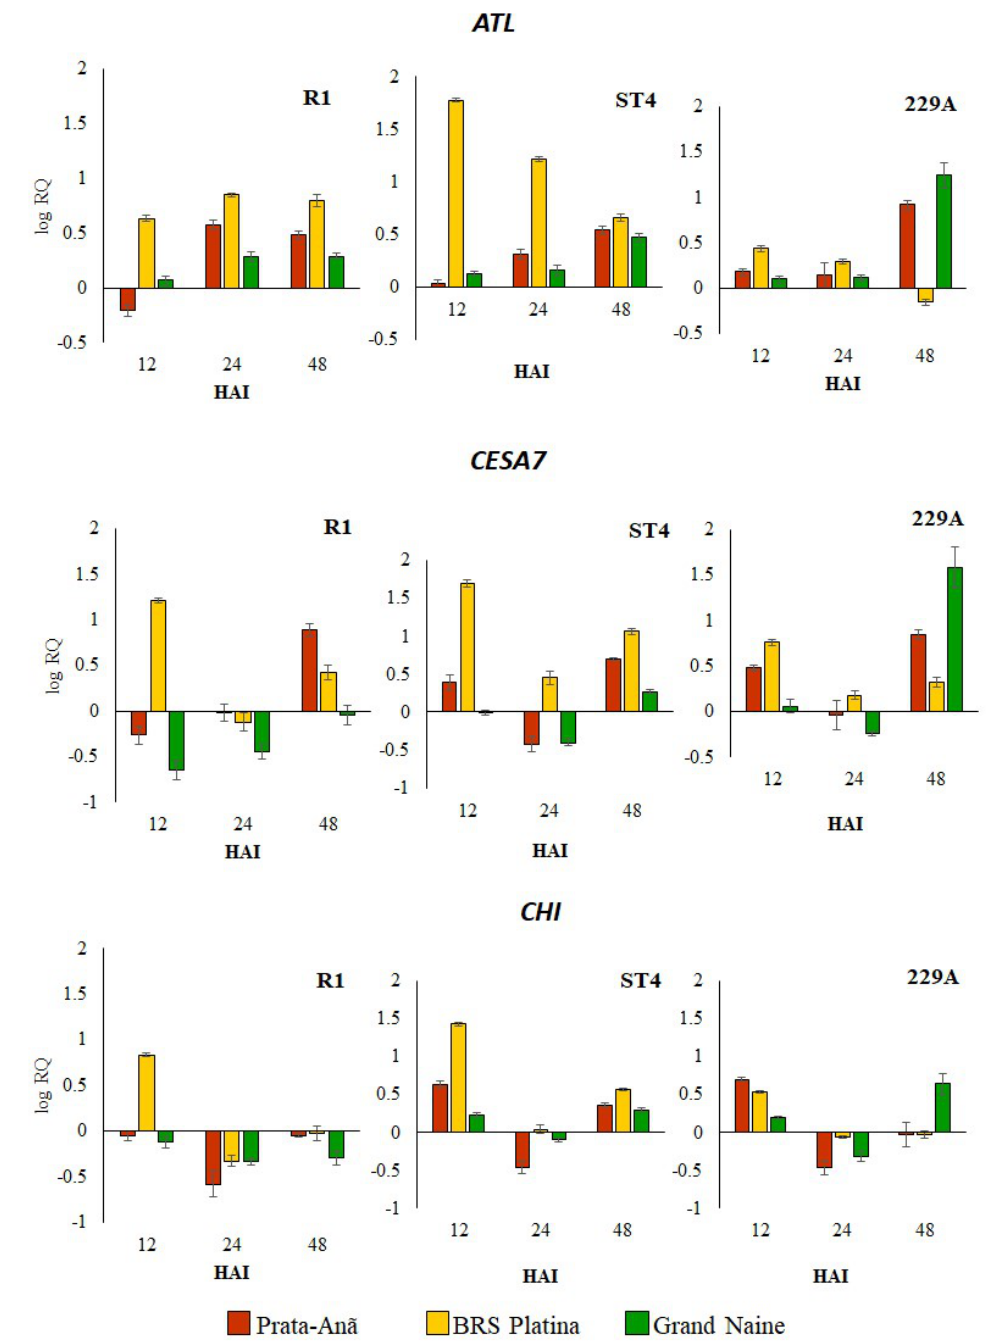
Figure 1. Relative expression levels of three defense-related genes in banana genotypes at 12, 24 and 48 h after inoculation (HAI) with Fusarium oxysporum f. sp. cubense races 1 (Foc R1), subtropical 4 (Foc ST4) and isolate 229A. Levels of the relative expression of the defense-related genes Auxin transporter-like protein 1 (ALT), cellulose synthase A catalytic subunit 7 (CESA7) and chitinase (CHI) were analyzed by RT-qPCR. The data represent the means ± standard deviations of three biological replicates and three technical replicates. QR values correspond to genes with differential expression at 12, 24 and 48 h after inoculation (HAI) compared to 0 HAI (non-inoculated plants).